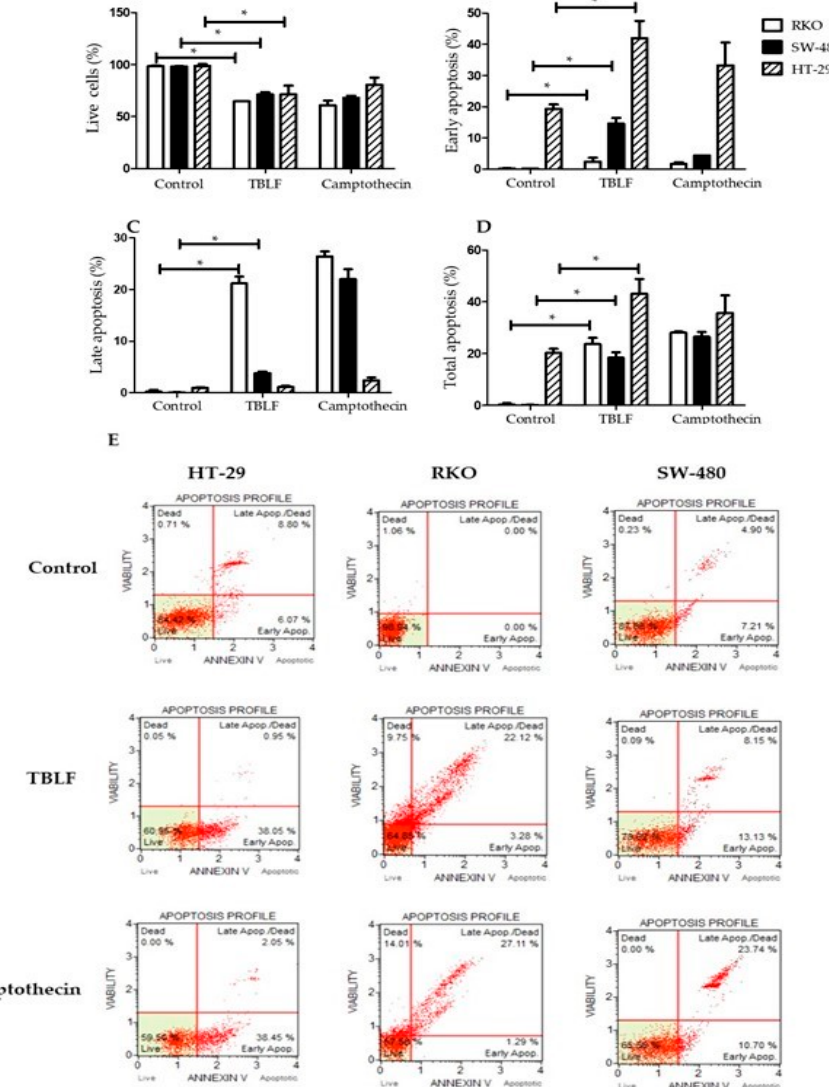
Figure 2. TBLF effect on apoptosis induction. Cells were treated for 8 h with the lethal concentration (LC 50 ). ( A ) Live cells, ( B ) early apoptosis, ( C ) late apoptosis, ( D ) total apoptosis. Camptothecin (5 μ M) was used as a positive control and 0.5% bovine serum albumin (BSA) as a negative control. ( E ) Flow cytometry representative dot plots are shown. (*) Statistically significant di ff erence (Student t test, p ≤